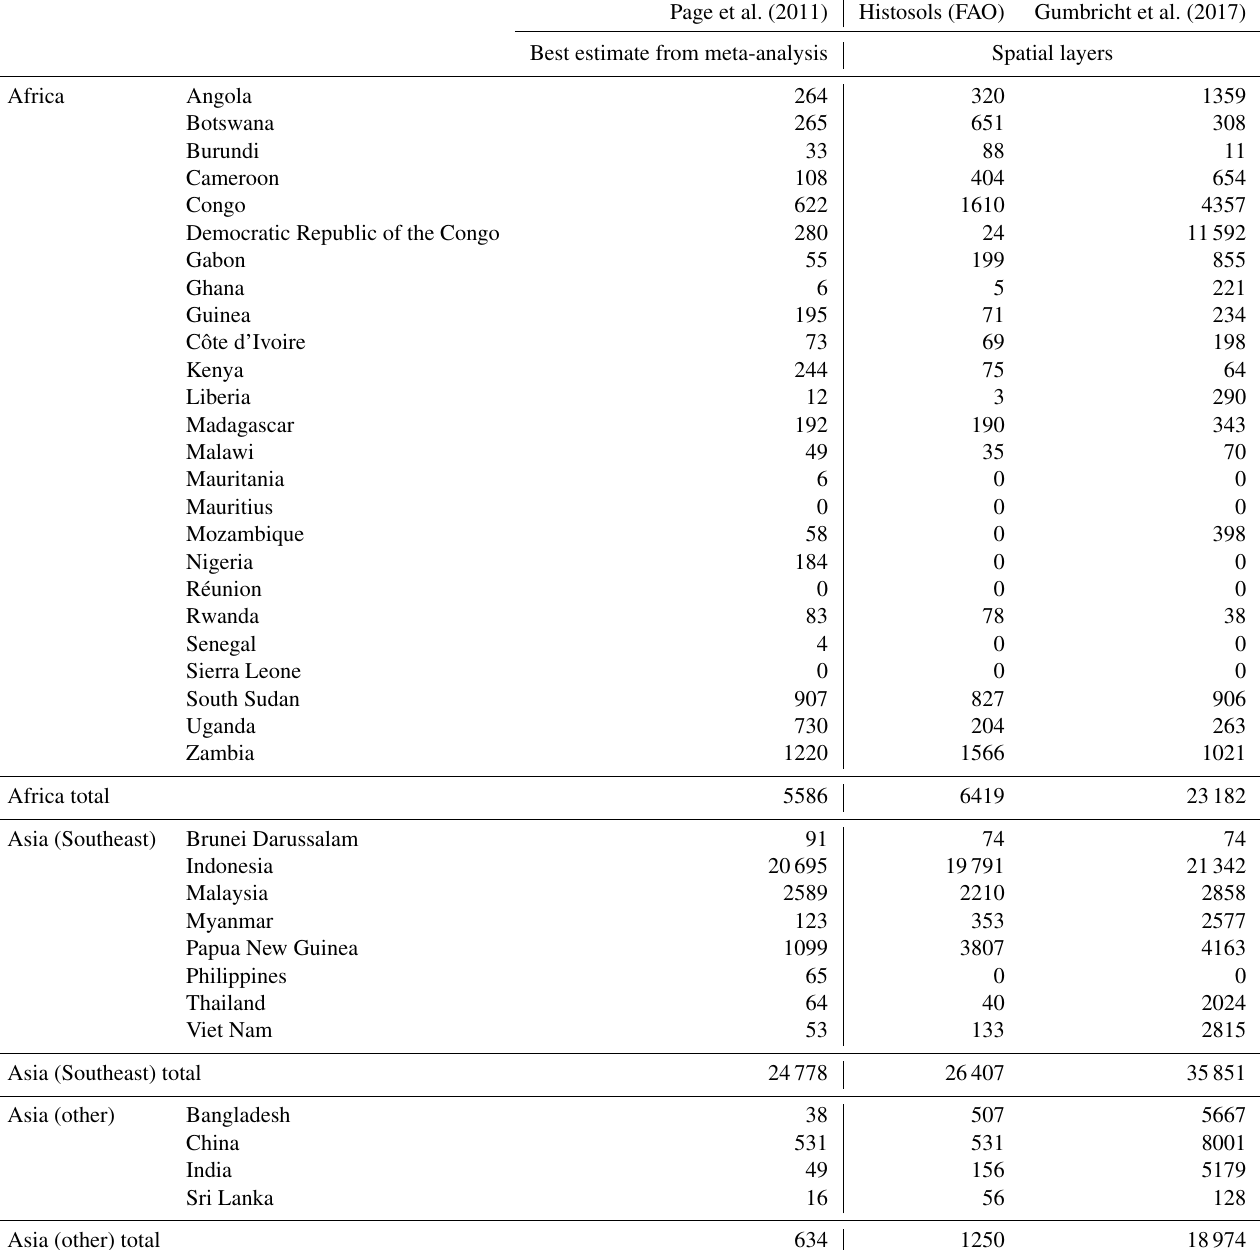
Table B1. Peat extent from Page et al. (2011), Gumbricht et al. (2017) and FAO area of histosols, all in